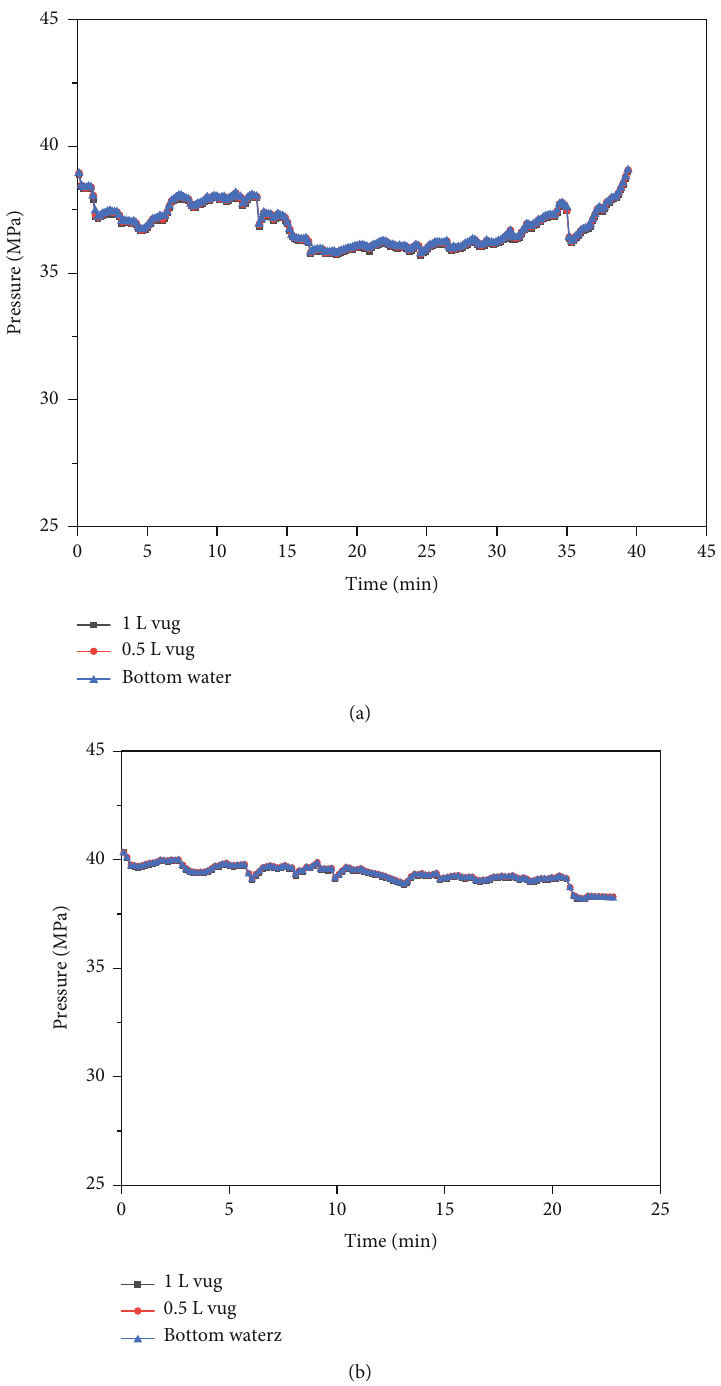
Figure 13: Pressure variation curves for high-pressure physical property experiments on reservoirs with constant-pressure bottom water and production rate of 20mL/min ((a) production well linked with 1L vug and (b) production well linked with 0.5L